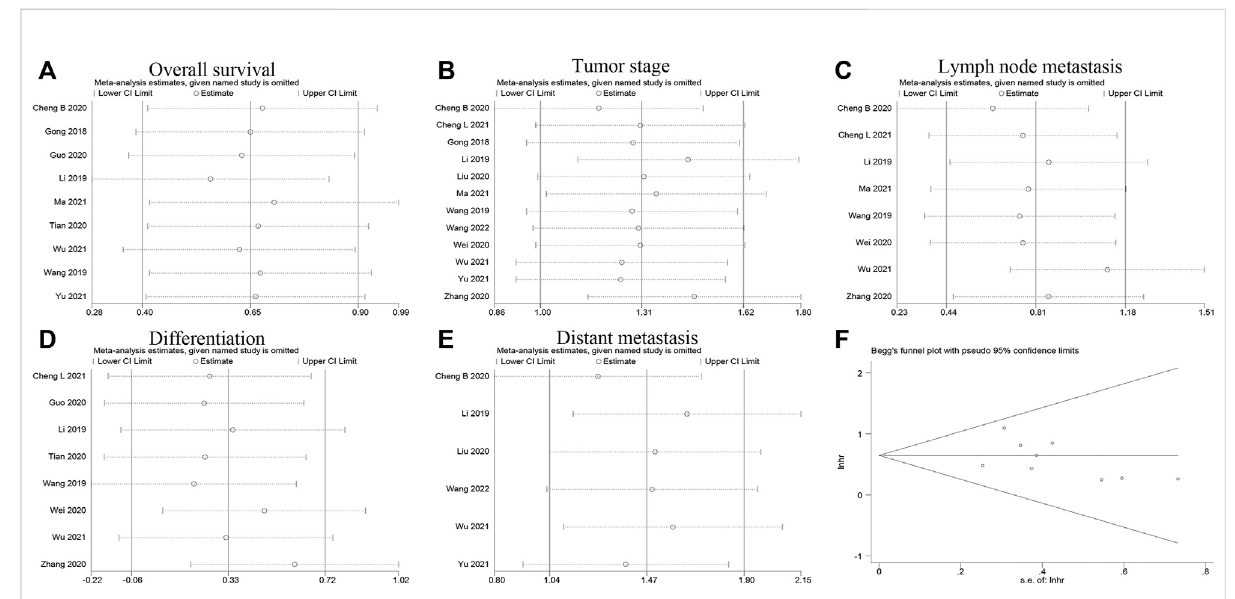
FIGURE 5 SensitivityanalysisandBegg ’ sfunnelplotofLINC00662. (A) SensitivityanalysisofpooledHRforoverallsurvival. (B) Sensitivityanalysisofpooled HR for tumor stage. (C) Sensitivity analysis of pooled HR for lymph node metastasis. (D) Sensitivity analysis of pooled HR for differentiation. (E) Sensitivity analysis of pooled HR for distant metastasis. (F) Begg ’ s funnel plot of LINC00662 for overall survival.